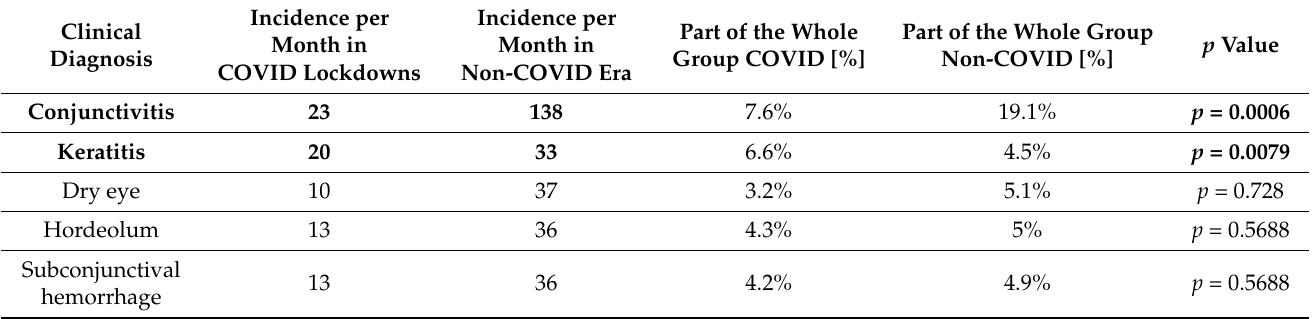
Table 3. Prevalence of anterior segment and adnexae disorders in COVID lockdowns (16th of